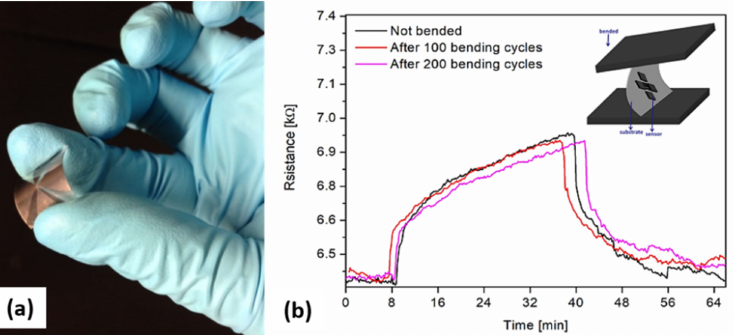
Figure 7. ( a ) Image of a flexible laser-printed CNW-based sensor. ( b ) Real-time measurement of a flexible laser-printed CNW-based sensor to 20 ppm of NH 2 without any bending and after 100 and 200 bending cycles.